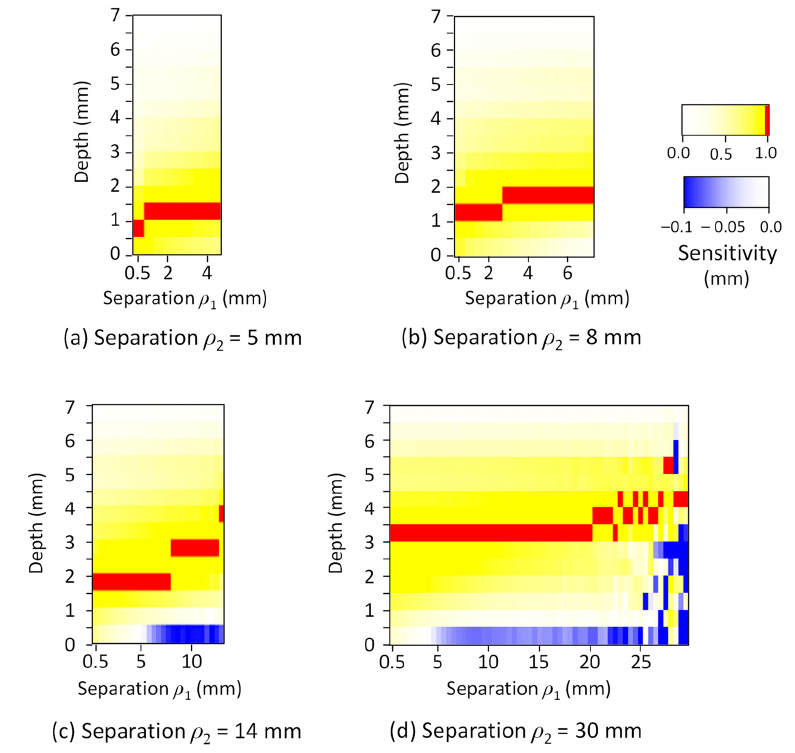
Figure 5. The mapping result of the normalized sensitivity–depth curve in the gastric tissue model. ρ 2 was changed to ( a ) 5 mm, ( b ) 8 mm, ( c ) 14 mm, and ( d ) 30 mm.